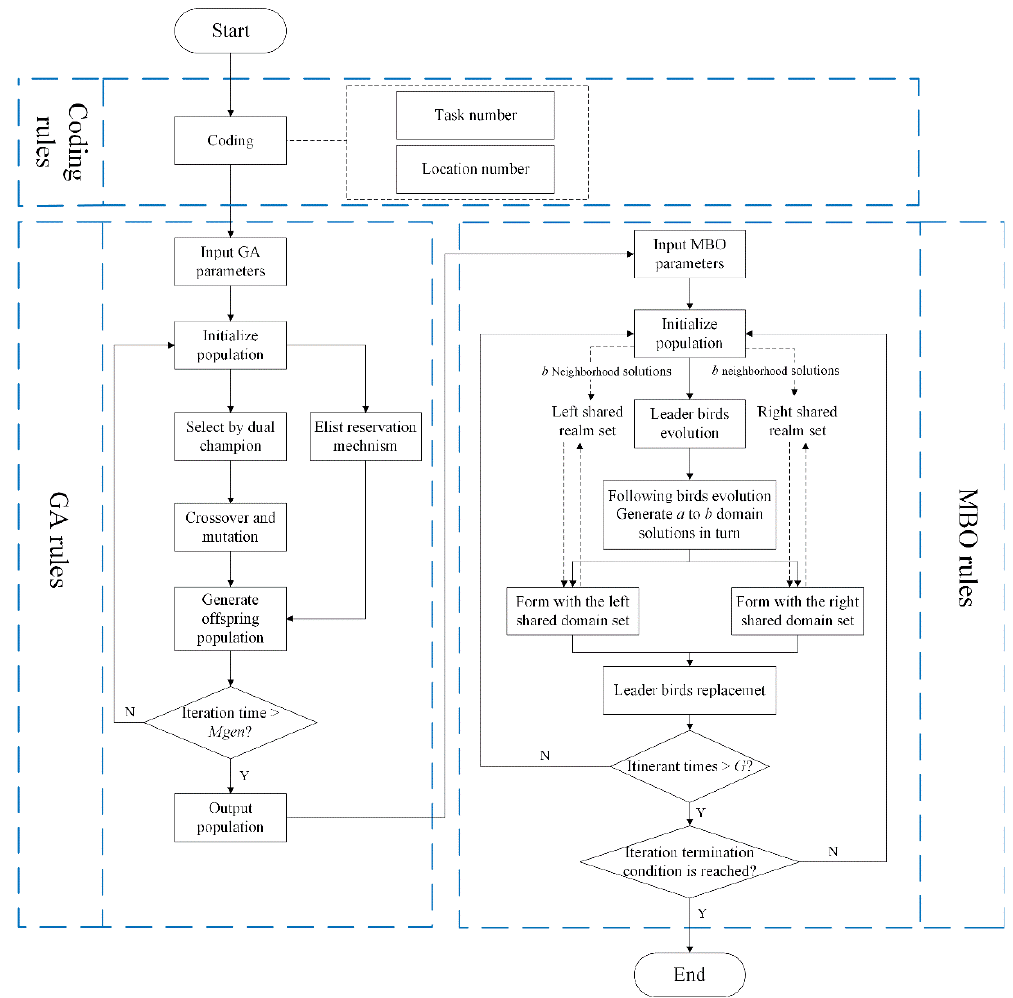
Figure 3. Flow chart of GA ‐ MBO.